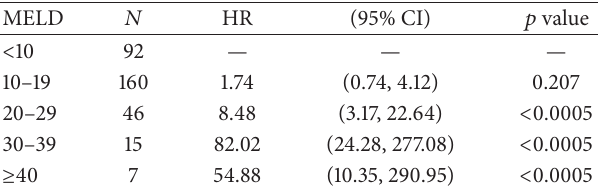
Table 4: Cox proportional hazards models for 1-year wait list mortality for different MELD strata.